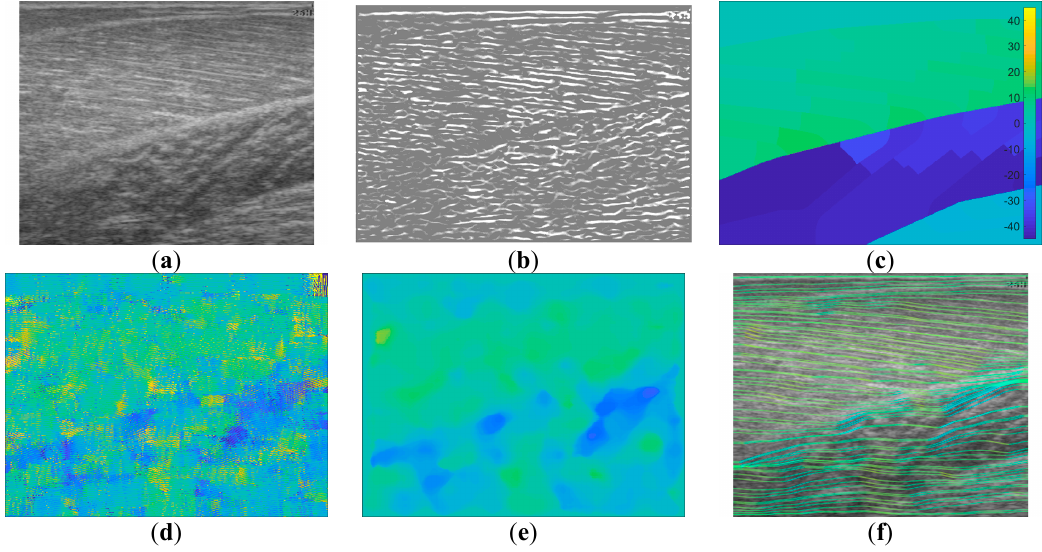
Figure 3. Representative wavelet visual result. ( a ) shows the raw image, ( b ) shows the vessel-enhanced image (contrast-enhanced for clarity), ( c ) shows the ground truth, ( d ) shows the result of Gabor wavelet convolution with ( b , e ) shows the result of a (35 × 35) median filter applied to ( d , f ) shows line traces of ( e ). It is clear, when comparing ( e ) to ( c ), that the heatmaps partial match within the GM region, but almost not at all in the Sol region. The line trace visually confirms that the fibre traces are roughly aligned with the visible fibres in the raw image in the GM muscle and the second compartment of the Sol muscle only. The heatmap ( d , e ) does not consistently represent the segmentation of muscle compartments shown by the ground truth.